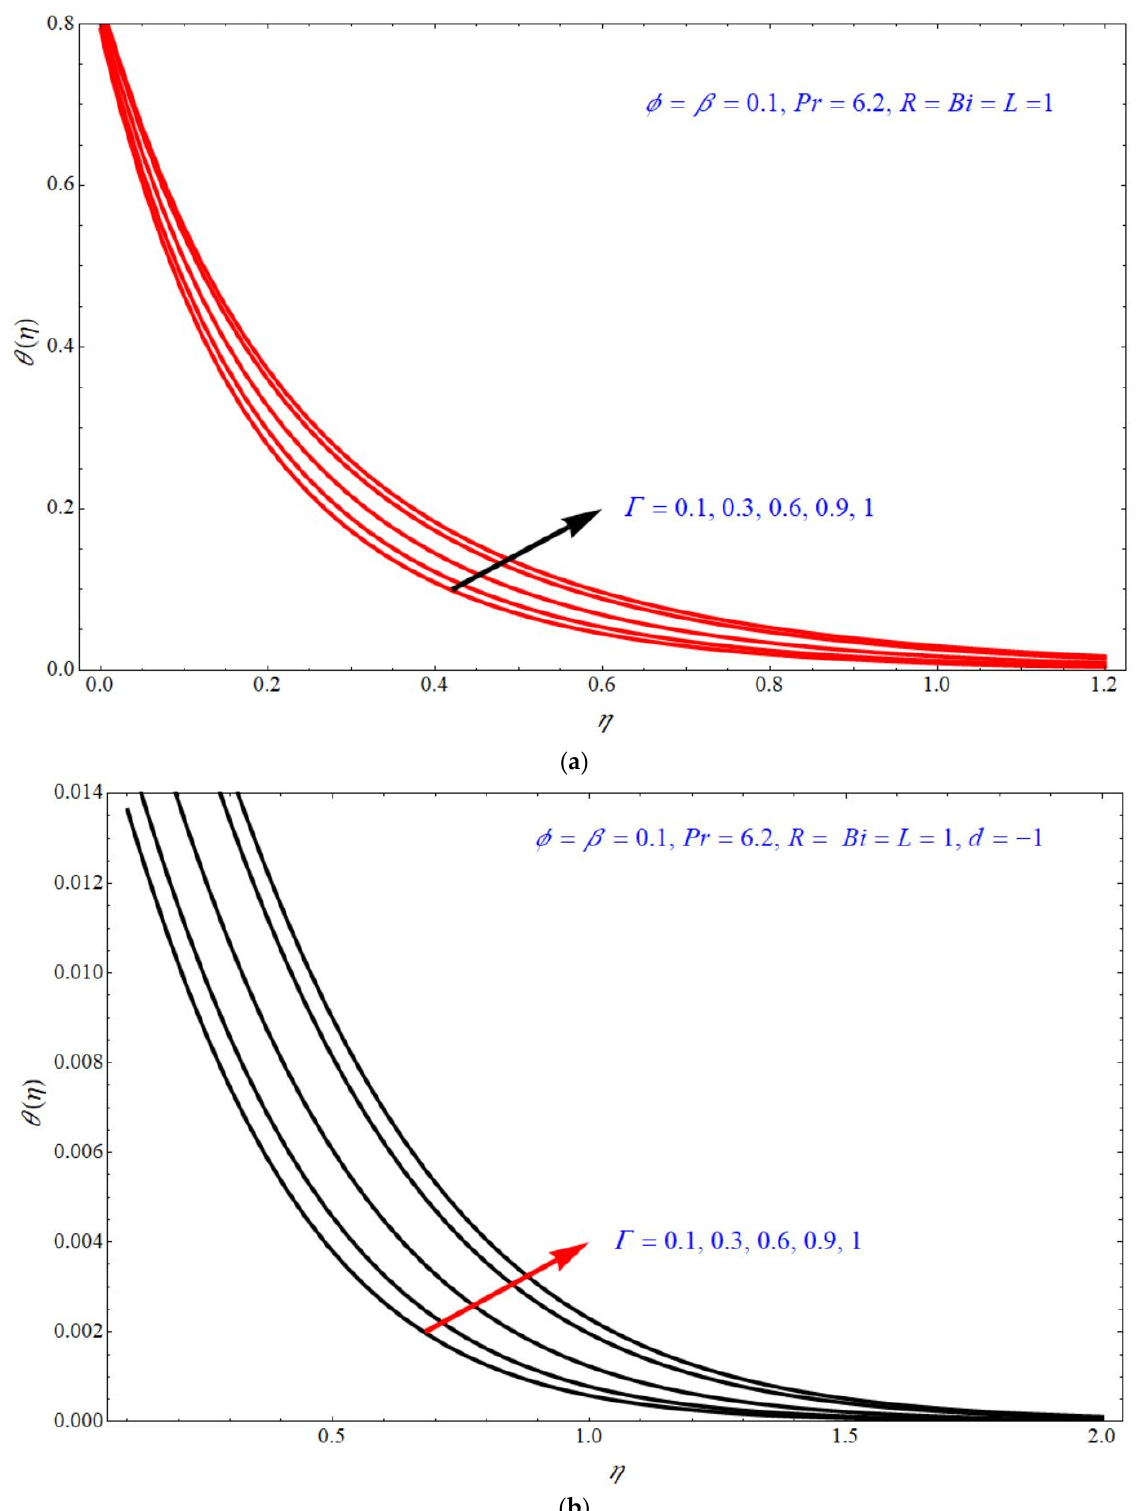
( ) θ η η on for different choices of